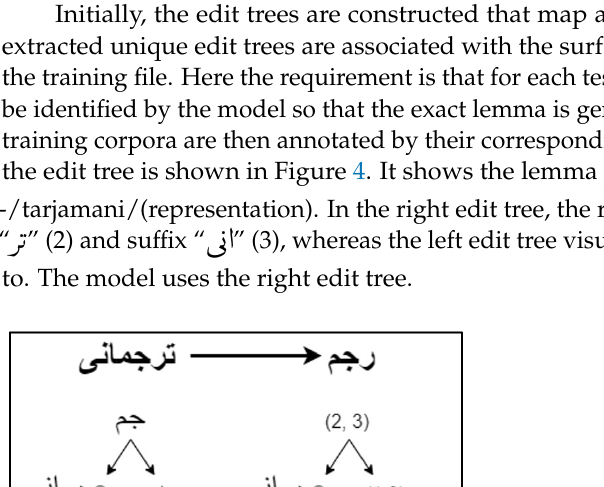
(cid:250)(cid:9) (cid:71)(cid:65)(cid:212)(cid:103)